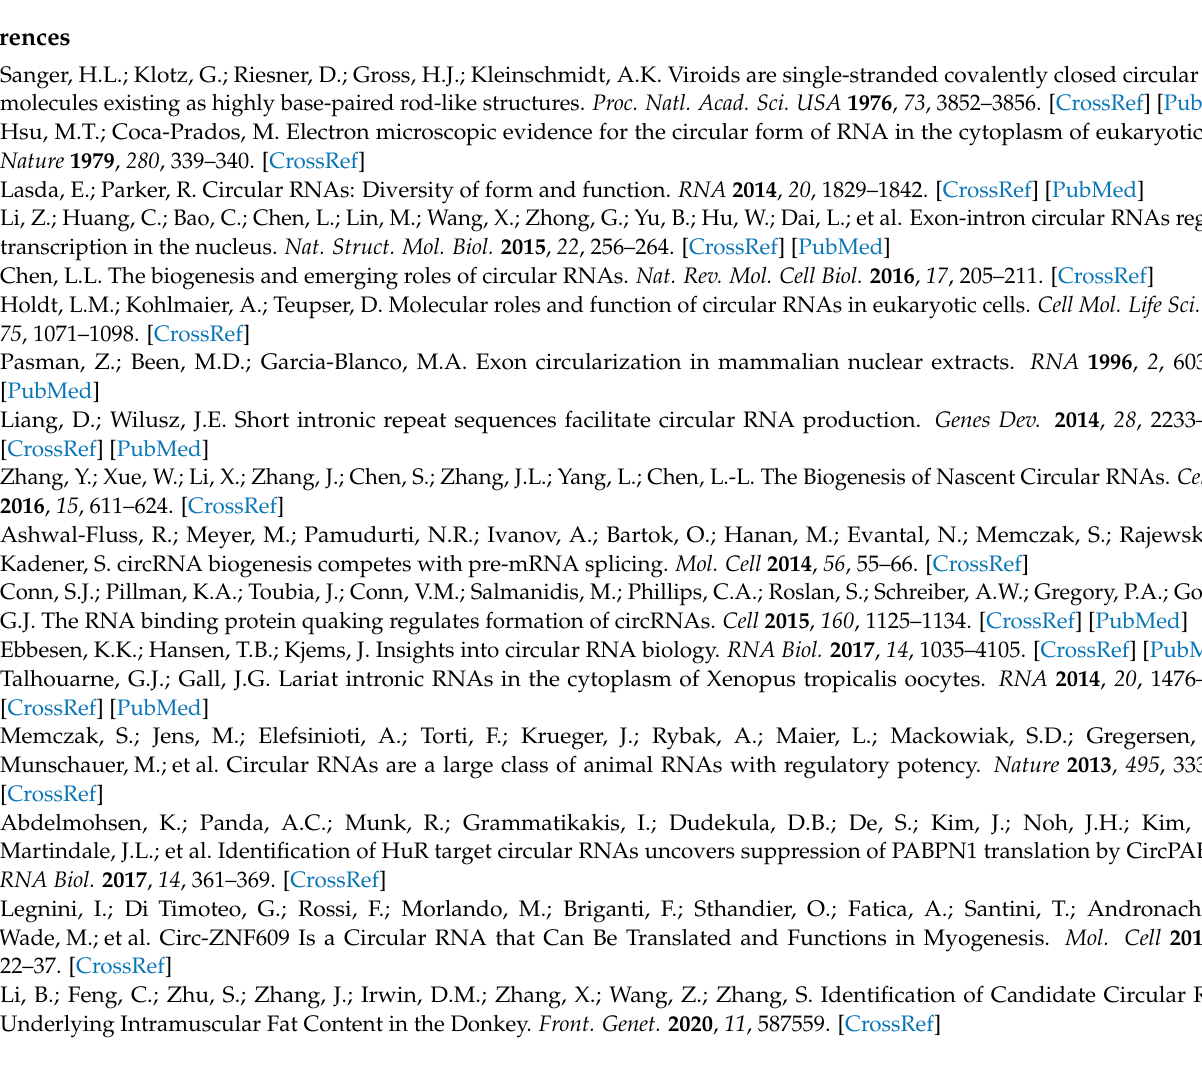
.3390/ncrna8010012/s1. Figure S1: Boric acid treatments do not affect the transcription of housekeep- ing genes, Figure S2: Identification of TIA-1-binding motifs on flicRNA sequences from Entamoeba histolytica , Figure S3: Identification of promoter elements in Entamoeba histolytica genes, Figure S4: R treatment, Table S1: Entamoeba invadens orthologs and paralogs of E. histolytica virulence-related genes, Table S2: PCR